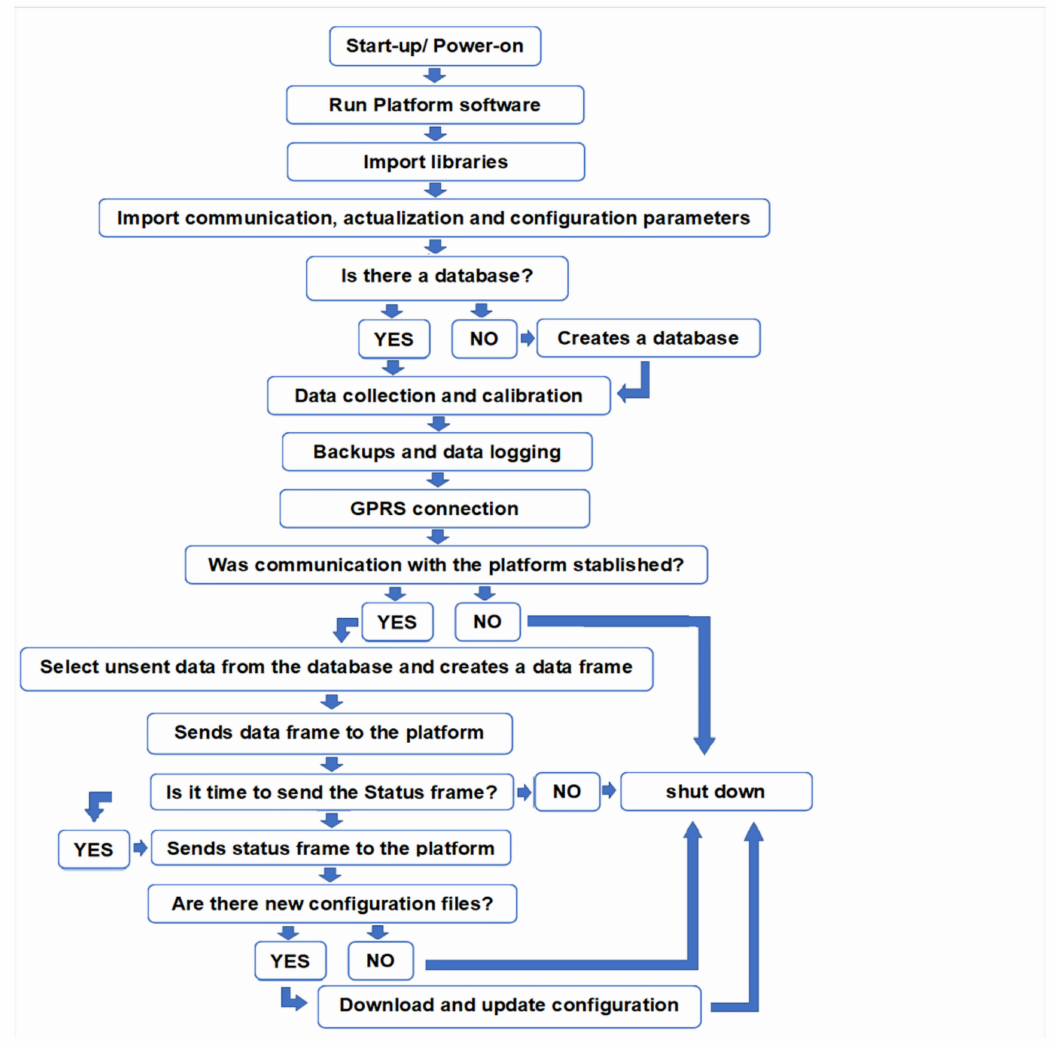
Figure 4. Operation